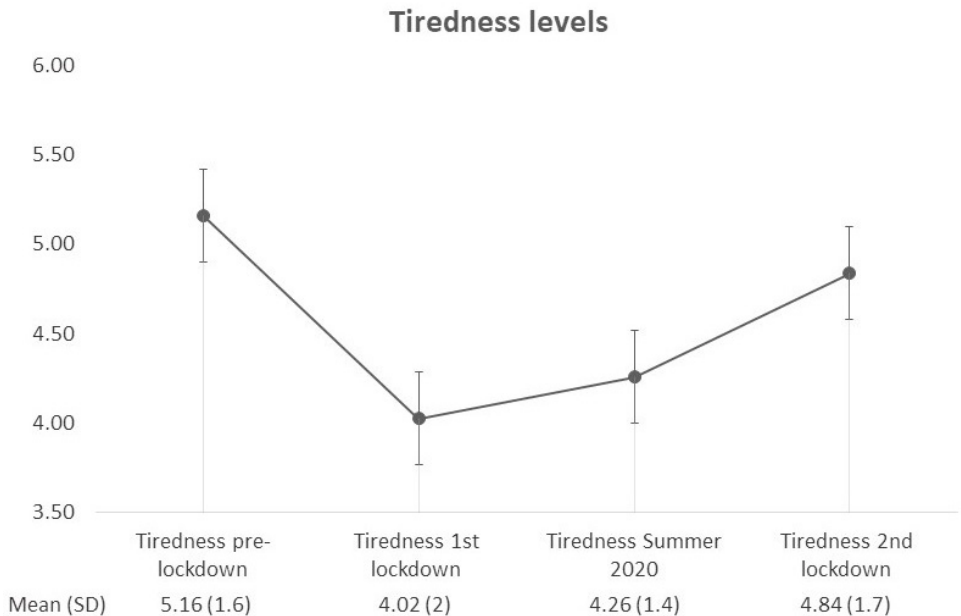
Figure 2. Tiredness levels of our sample of individuals with HF-ASD at the four time-points assessed. Abbreviations: SD = Standard Deviation.